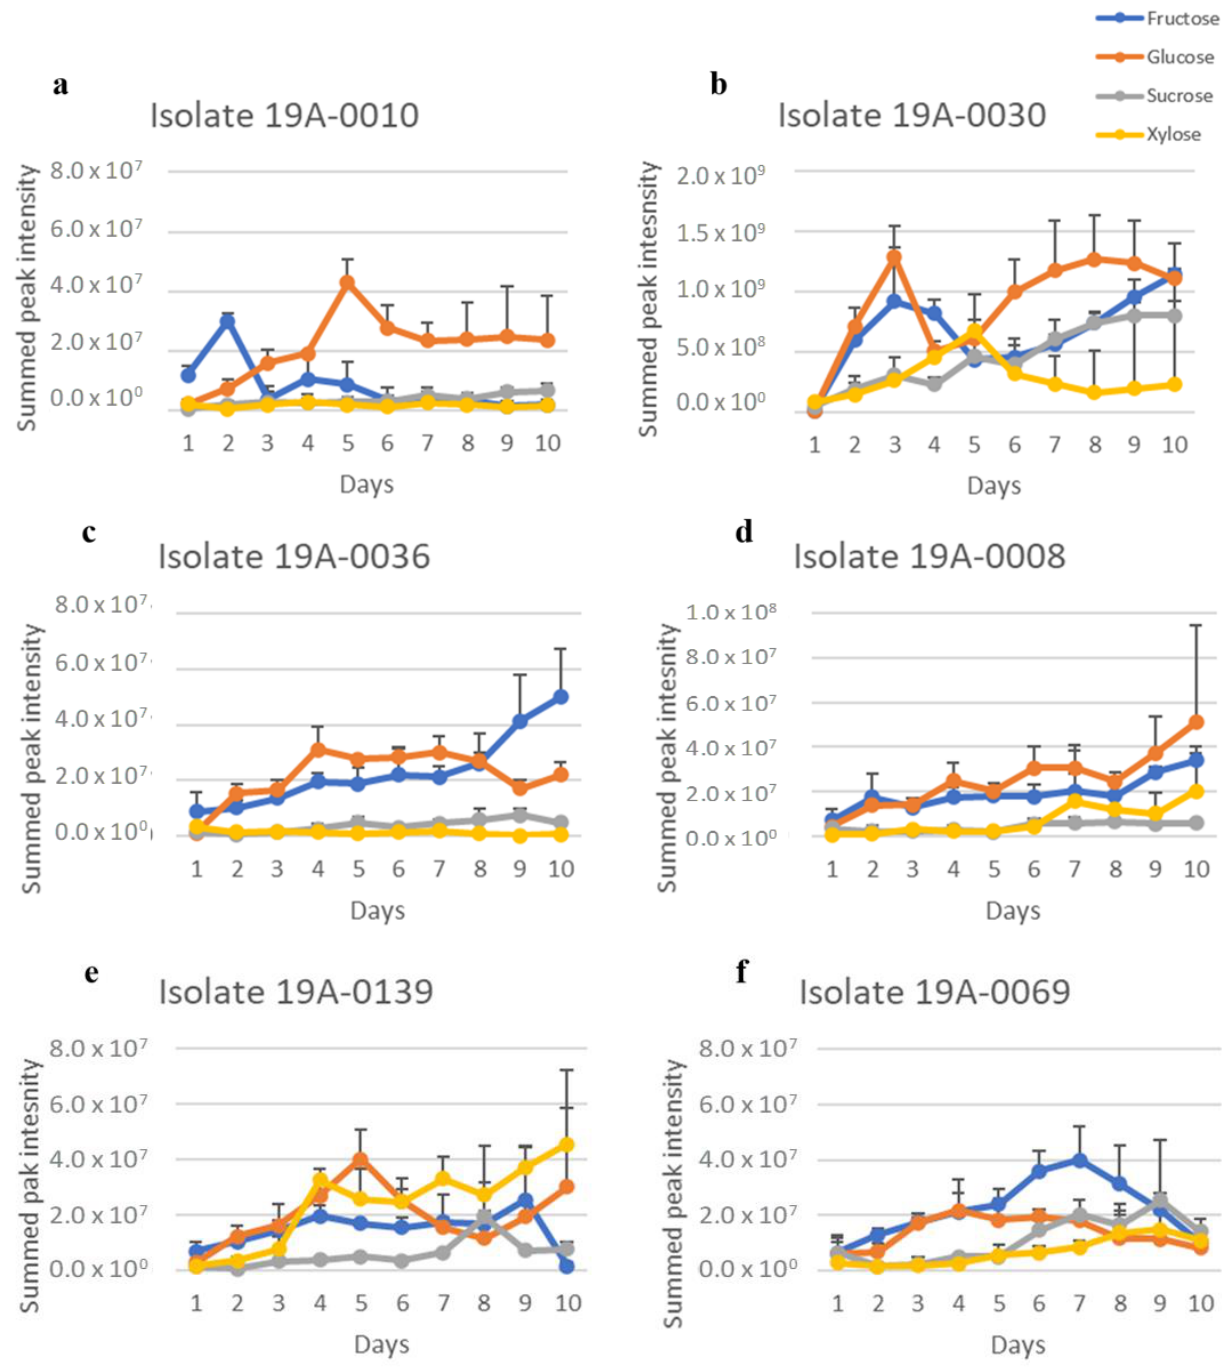
Figure 5. Lactic acid production of R. stolonifer isolates in the presence of glucose, fructose, sucrose, or xylose, along with asparagine as a nitrogen source. Data presented are the relative concentration of lactic acid (as determined from NMR) with standard deviation (error bars), n = 3. ( a ) Isolate 19A – 0010, ( b ) isolate 19A – 0030, ( c ) isolate 19A – 0036, ( d ) isolate 19A – 0008, ( e ) isolate 19A – 0139, ( f ) isolate 19A – 0069.